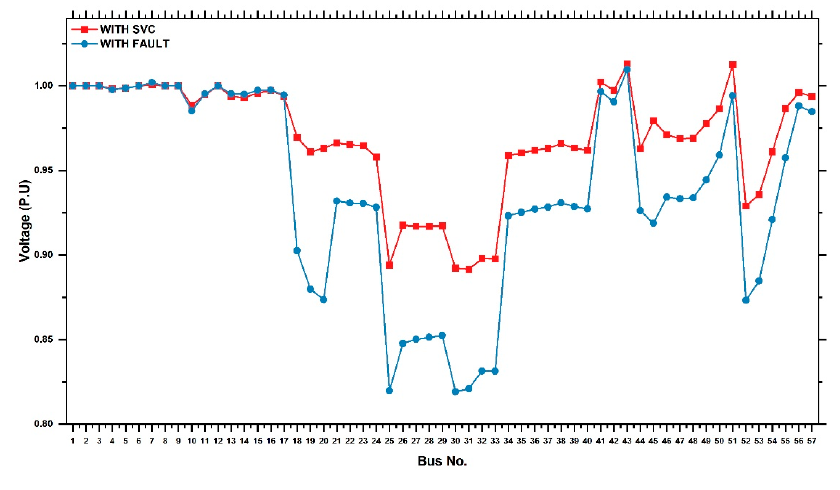
Figure 19. Integration of a SVC.